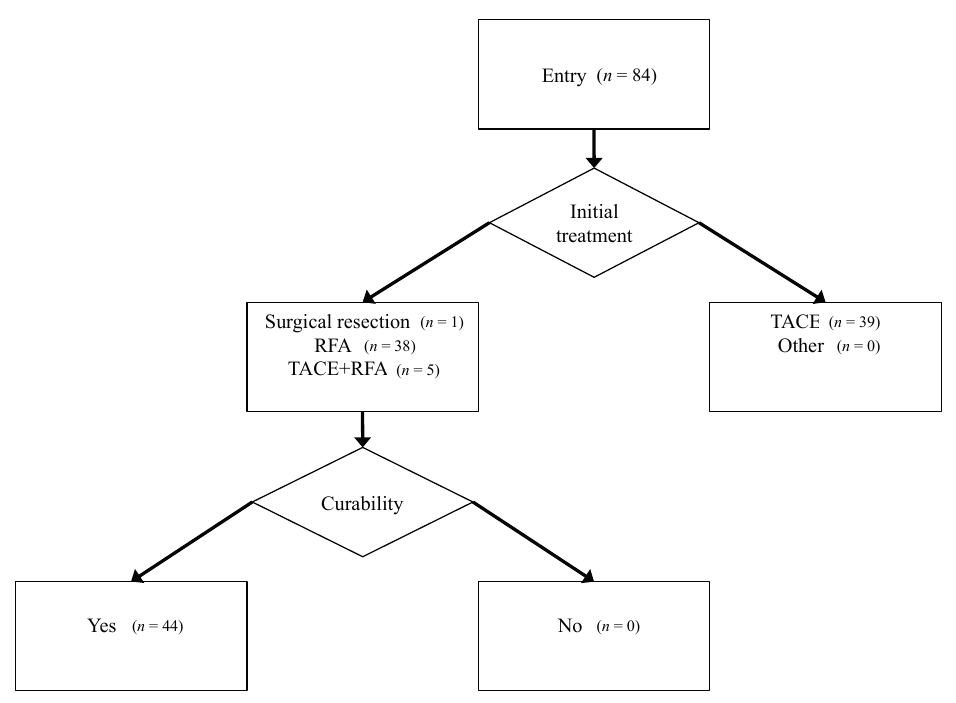
Figure 3. Patient flow, treatment selection, and